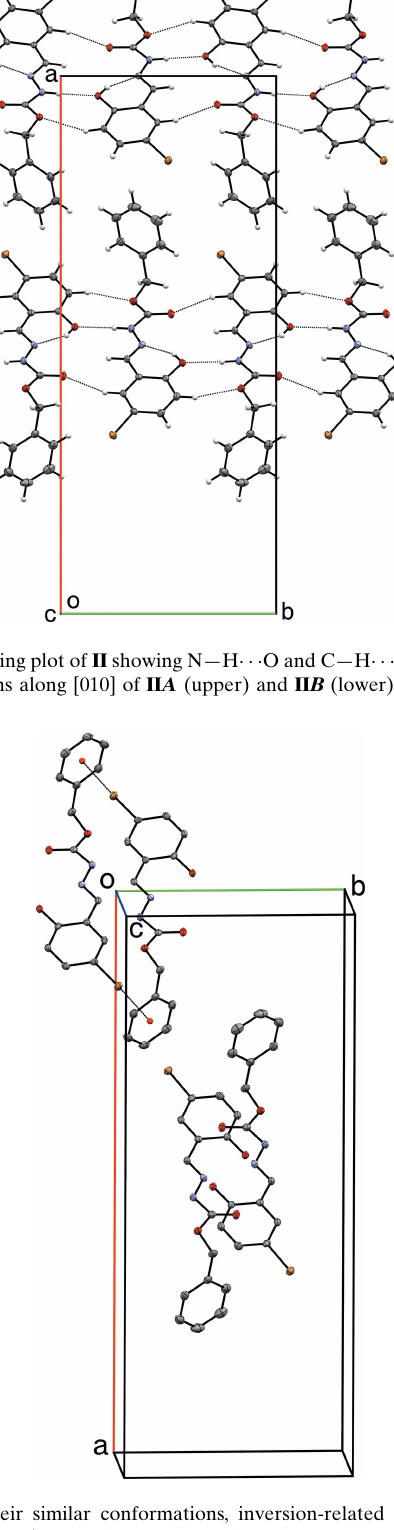
Figure 5 A partial packing plot of I showing hydrogen bonding as dashed lines. N—H (cid:2)(cid:2)(cid:2) O and a pair of C—H (cid:2)(cid:2)(cid:2) O (bifurcated) hydrogen bonds link n - glide-related molecules into layers parallel to ac .